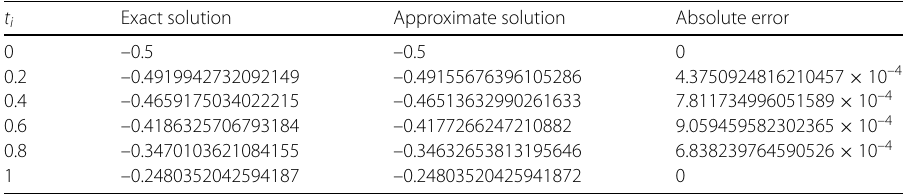
Table 3 The absolute errors of approximating y 1, α for (1,1)-system at various t and α = 0.5